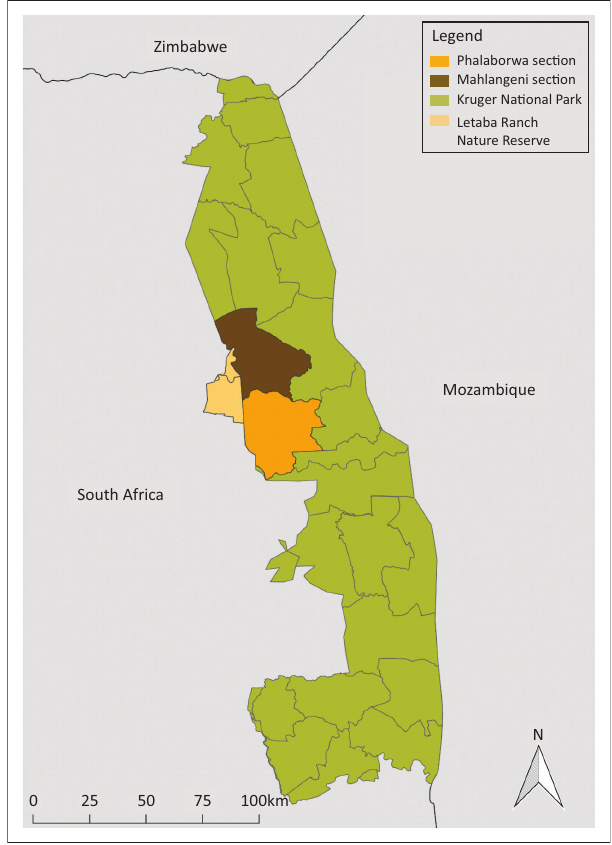
km, kilometres. FIGURE 1: Location of study